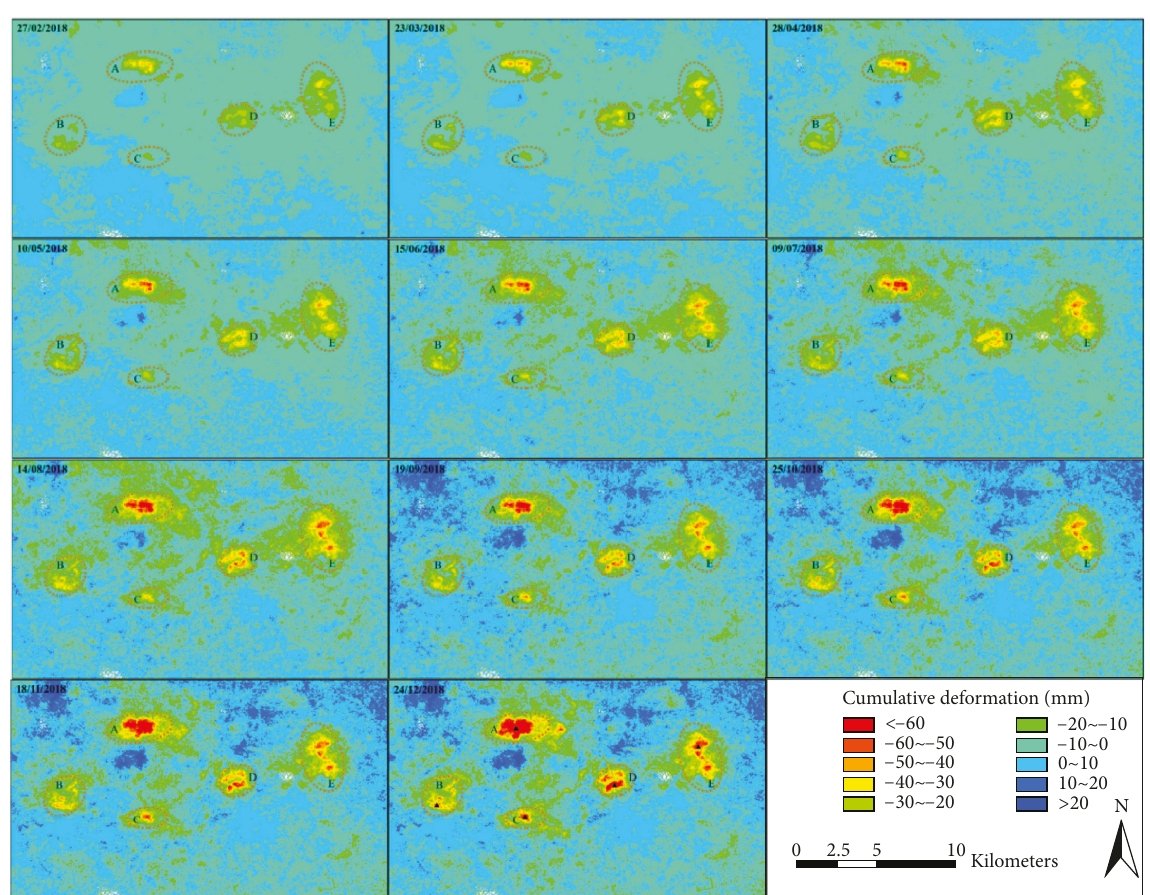
Figure 10: Cumulative deformation map of time series in 2018 in Zhanhua district (with reference to 10 January 2018). The date of obtaining the deformation map is marked in the upper left corner of each map, and the number of the subsidence area is marked in the ellipse. The triangle up in the last image denotes the point where the subsidence curve is